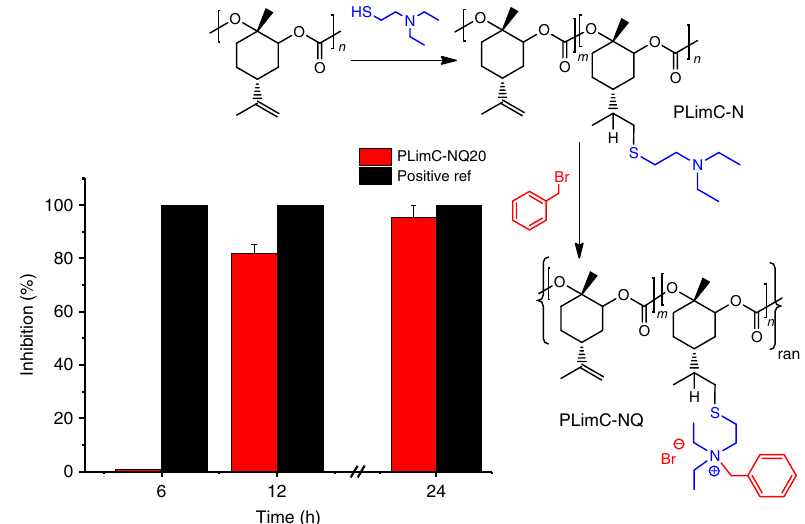
Figure 4 | The transformation into antibacterial PLimC. Schematic of the functionalization of PLimC with a tertiary amine (PLimC-N) and the subsequent quaternization with a benzyl moiety (PLimC-NQ). In the column diagram, the bacterial inhibition performances of PLimC-NQ20 and a positive reference material (polyhexamethylene guanidine hydrochloride, PHMG) relative to pure PLimC in a shaking flask experiment; tested on E. coli bacteria in buffer solution with polymer films (20mgml (cid:2) 1 ) at 20 (cid:2) C are illustrated. The inhibition was calculated by determination of the cfu of tenfold diluted dispersions spread on agar plates (Supplementary Table